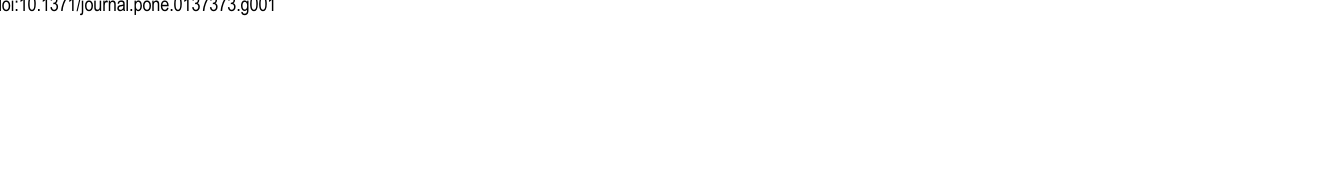
PLOS ONE | DOI:10.1371/journal.pone.0137373 September 1, 2015 2 /